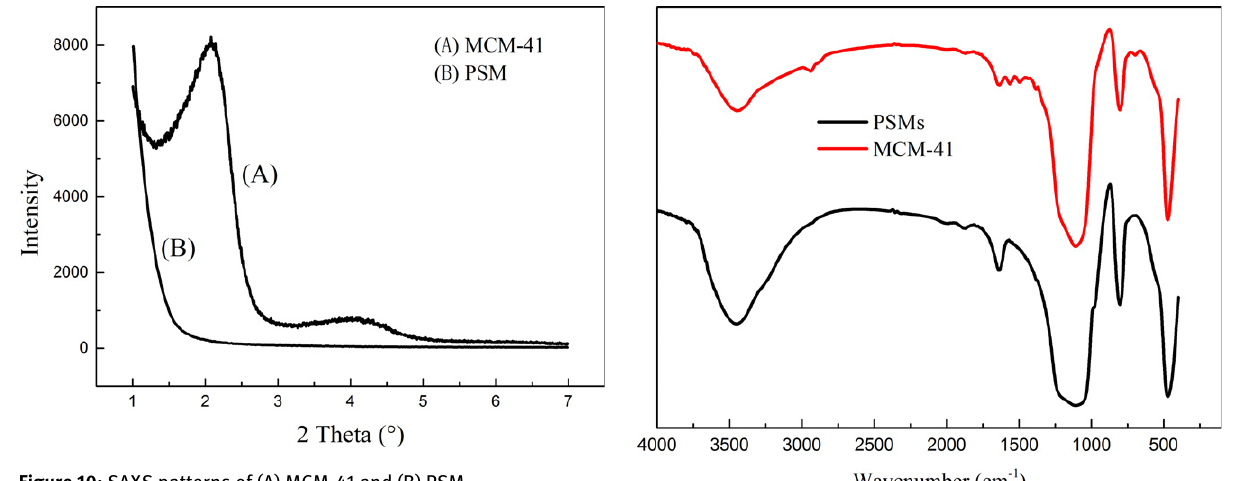
Figure 10: SAXS patterns of (A) MCM-41 and (B) PSM